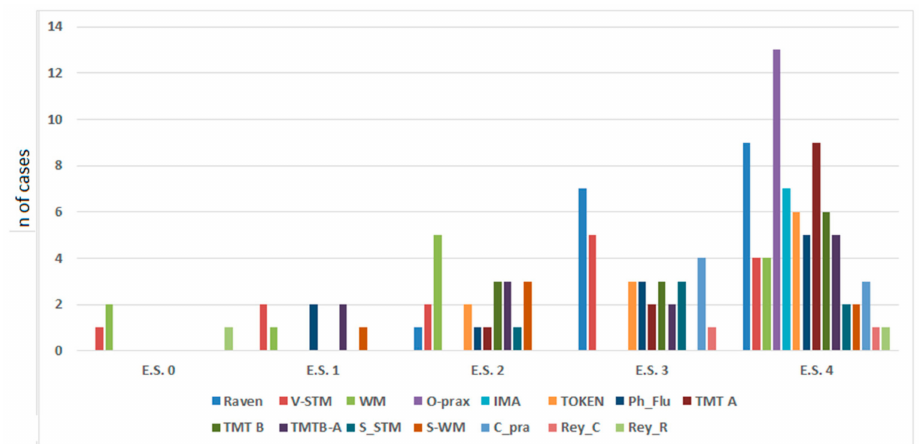
Figure 1. Left hemisphere (LH) and right hemisphere (RH) iLGG patients’ neuropsychological level of performance stratified by their equivalent score, showing a higher distribution of performance in the equivalent scores of 3 and 4 for all the